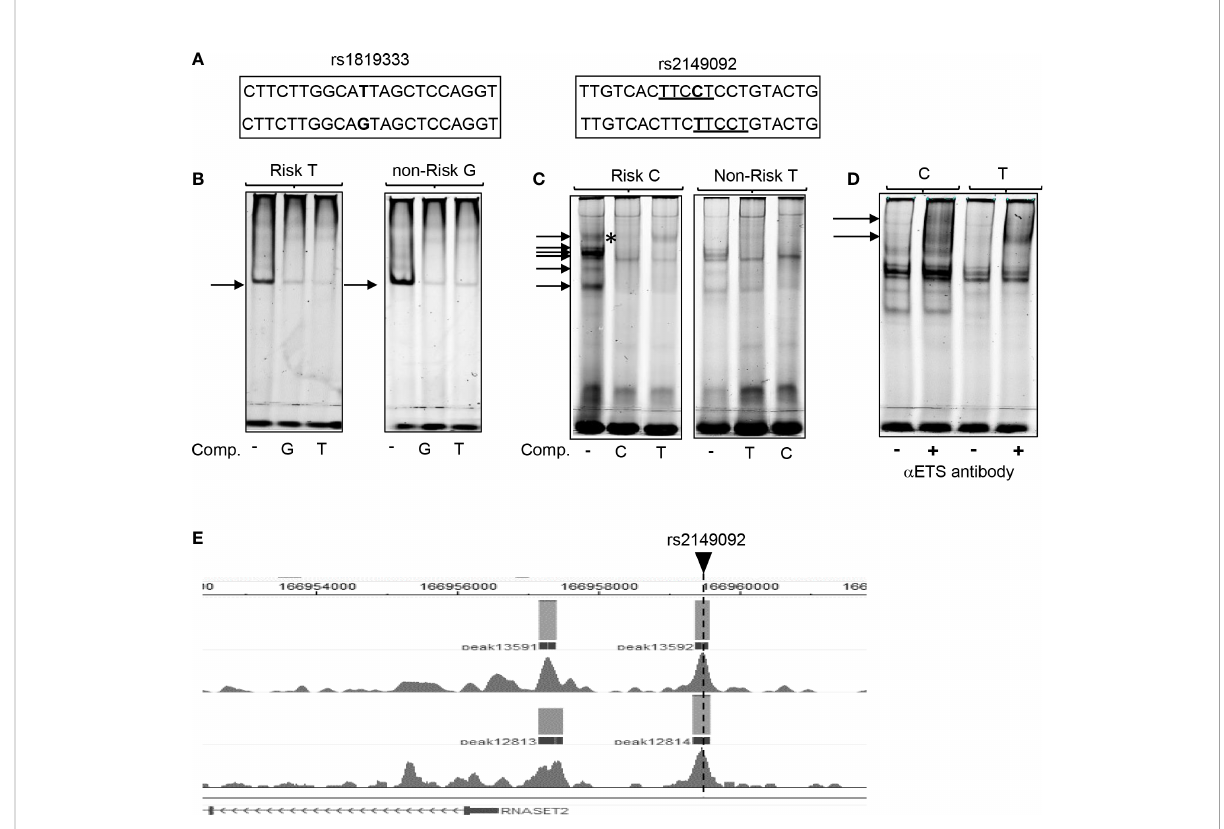
FIGURE 2 Allele speci fi c nucleo-protein binding to RNASET2 promoter regions. (A) Sequence of rs1819333 and rs2149092 oligonucleotide probes. ETS1 TFBS are underlined. (B – D) EMSA analysis using nuclear extract from CD4 + T cells binding to (B) rs1819333 (C) rs2149092 or (D) rs2149092 supershifted complexes in the presence of ETS1-speci fi c antibody. (E) ETS1 Chip-seq data from human puri fi ed T cells (FANTOM project). Unlabeled oligo competitors (comp): rs2149092 C or T SNP. Representative of 2-4